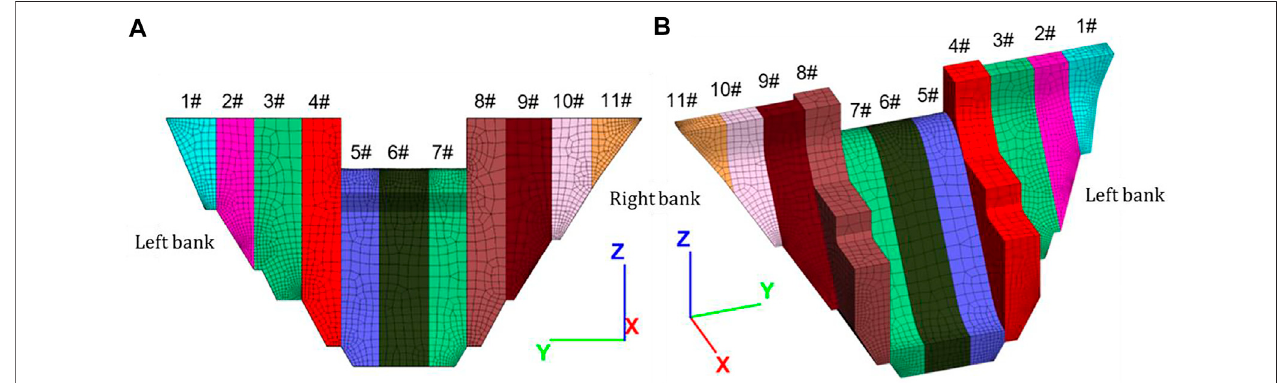
FIGURE 2 | The numerical model of the RCC gravity dam of the Kala hydropower station: (A) upstream view, (B) downstream view.